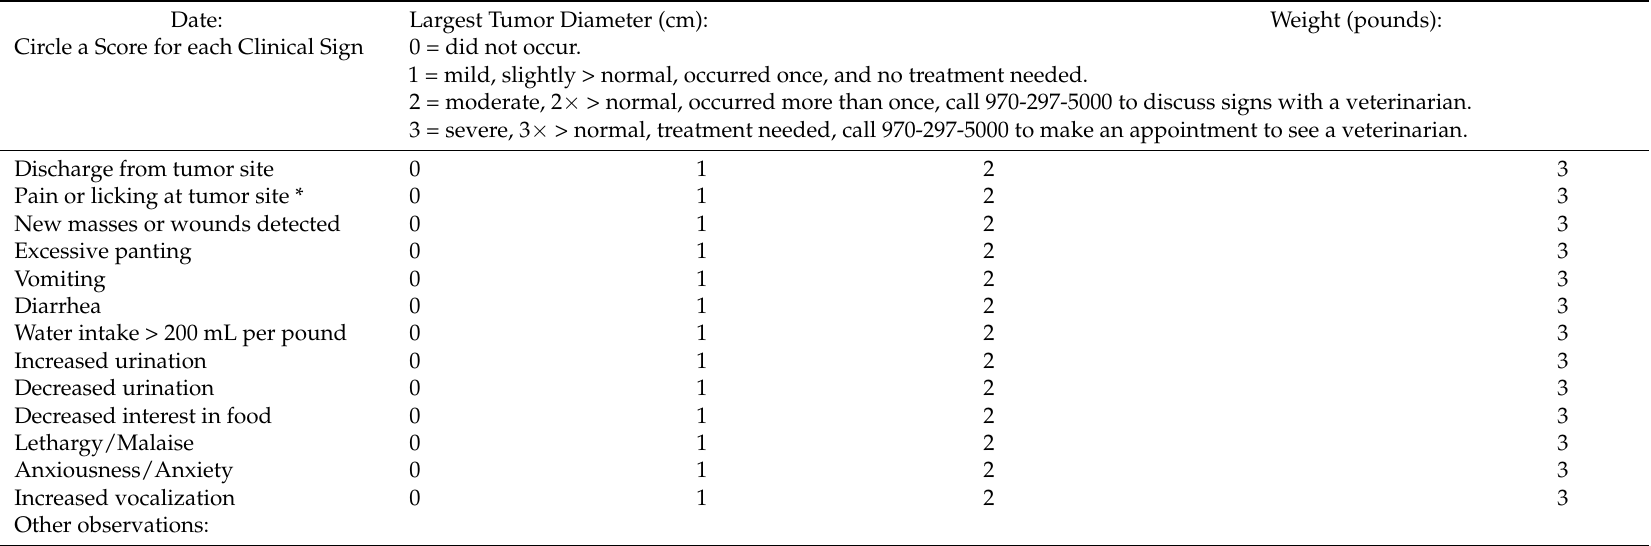
Table A2. Clinical score sheet filled out daily for dogs treated with intratumoral MYXV ∆